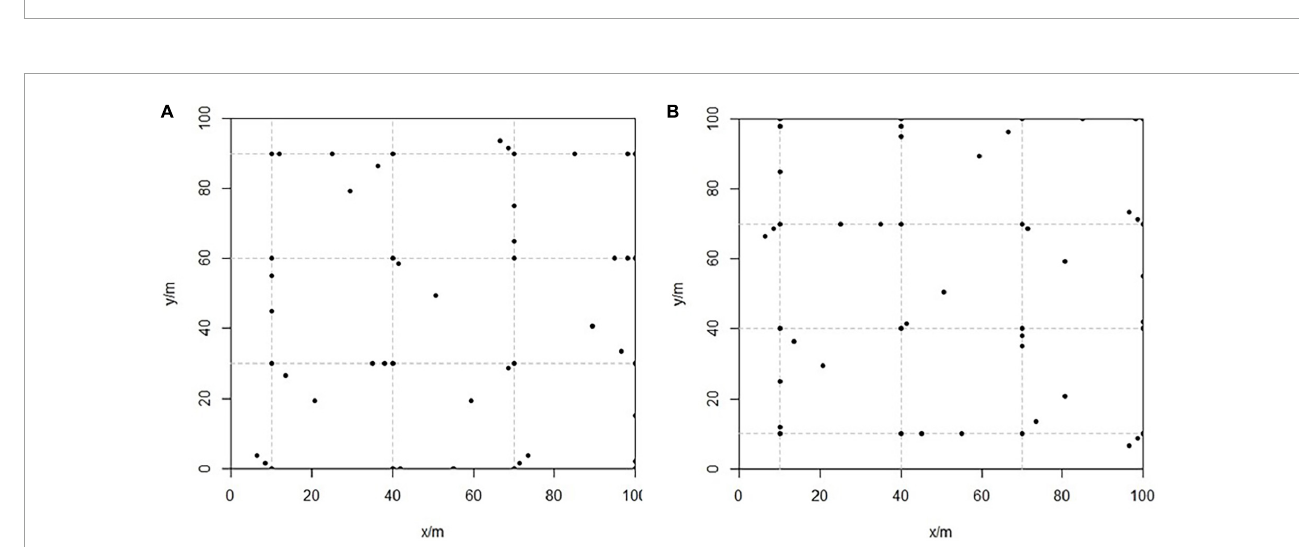
FIGURE5 Spatial distribution of soil sampling. (A) Mingled stand; (B) pure stand.